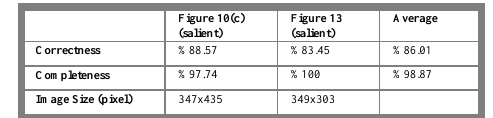
Table 6: Evaluation of Ziplock Snake for salient roads